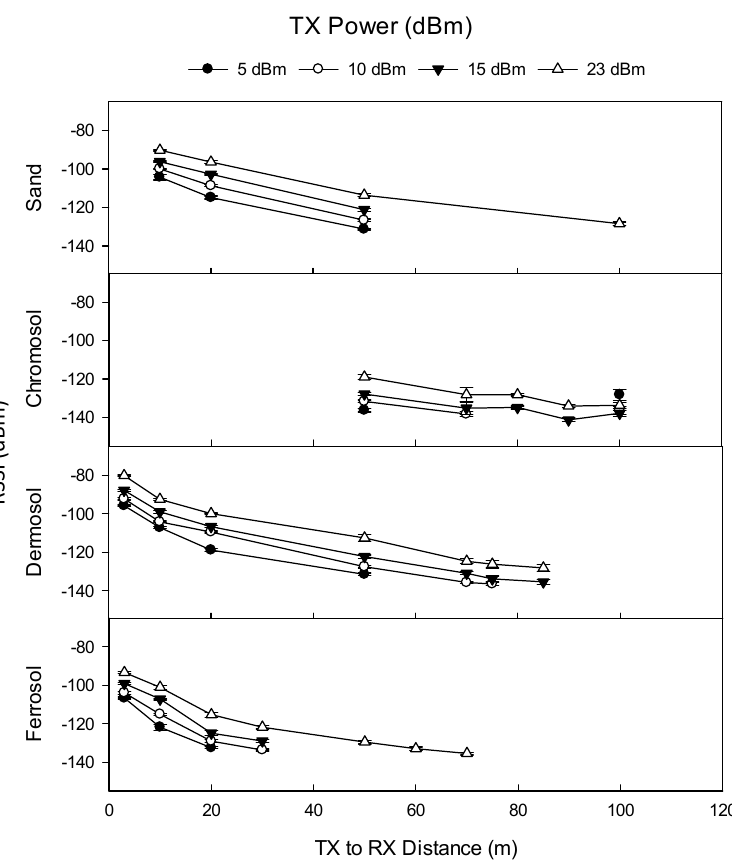
Figure 8. Effect of TX power (dBm) on RSSI by transmission distance by site (0.2 kbps data rate, 30 cm TX burial depth, 1/14 λ RX antenna). Sand is equivalent to Rudosol. RSSI (dBm) refers to received signal strength index, FE (Hz) refers to frequency error, and SNR refers to signal-to-noise ratio. Error bars indicate ±1 standard deviation.